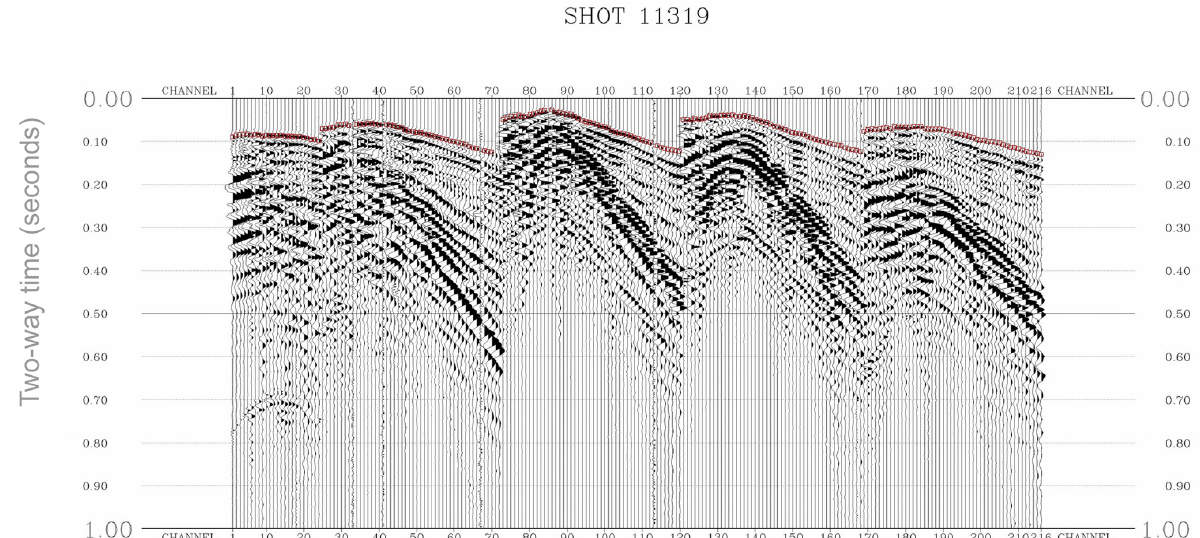
Figure 3. Example of shot gather recorded by the array of 10 GEODES seismic recorders (24 channels each). The red symbols indicate the travel-time picks of the firsts arrivals used as inputs for the tomographic inversion. Trace balancing (window times: 0–1500ms) has been applied to the data for display